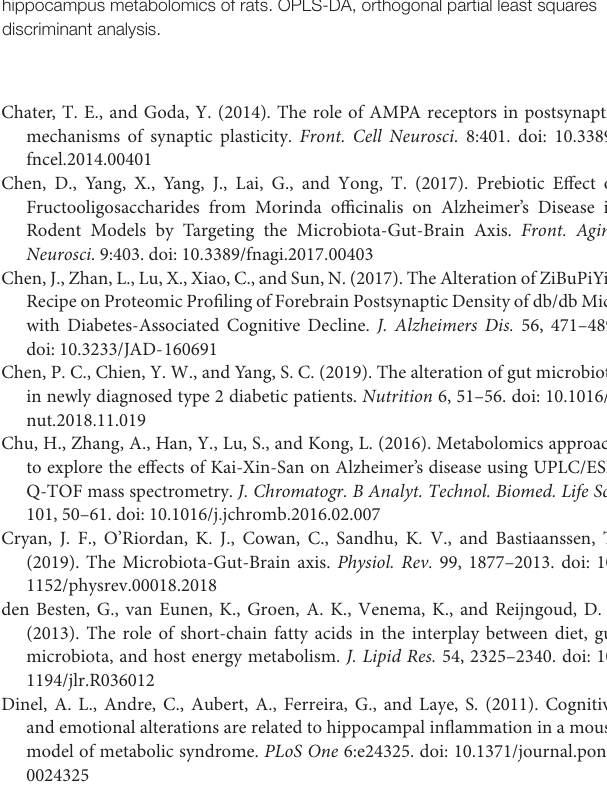
Supplementary Figure 1 | OGTT and ITT in rats. (A) OGTT measured in different groups. (B) ITT measured in different groups. Data are shown as mean ± SD. n = 7 per group. ∗∗ P < 0.01, ∗∗∗ P < 0.001, ∗∗∗∗ P < 0.0001, compared with the 15w-L group; # P < 0.05, ## P < 0.01, ### P < 0.001, #### P < 0.0001, compared with the 15w-Z group. OGTT, oral glucose tolerance test; ITT, insulin secretion test. Supplementary Figure 2 | BW and AC in rats. (A) BW measured in different groups. (B) AC measured in different groups. Data are shown as mean ± SD. n = 7 per group. ∗ P < 0.05, ∗∗∗ P < 0.001, ∗∗∗∗ P < 0.0001. BW, body weight; AC, abdominal circumference. Supplementary Figure 3 | Swimming speed in Morris water maze test of the orientation navigation test and the spatial exploration test. Data are shown as mean ± SD. n = 7 per group. D, day. Supplementary Figure 4 | OPLS-DA score plots for the different groups in the intestinal contents microbiology of rats. OPLS-DA, orthogonal partial least squares discriminant analysis. Supplementary Figure 5 | OPLS-DA score plots for the different groups in the intestinal contents metabolomics of rats. OPLS-DA, orthogonal partial least squares discriminant analysis. Supplementary Figure 6 | OPLS-DA score plots for the different groups in the hippocampus metabolomics of rats. OPLS-DA, orthogonal partial least squares discriminant